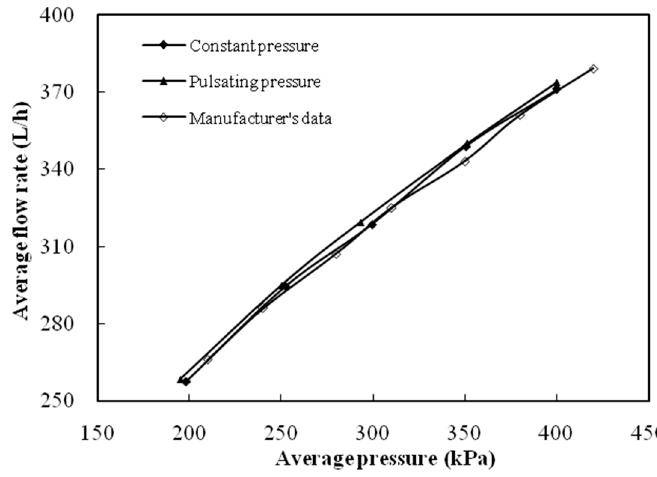
Figure 3. The relationship between flow rate and average pressure under different pressure